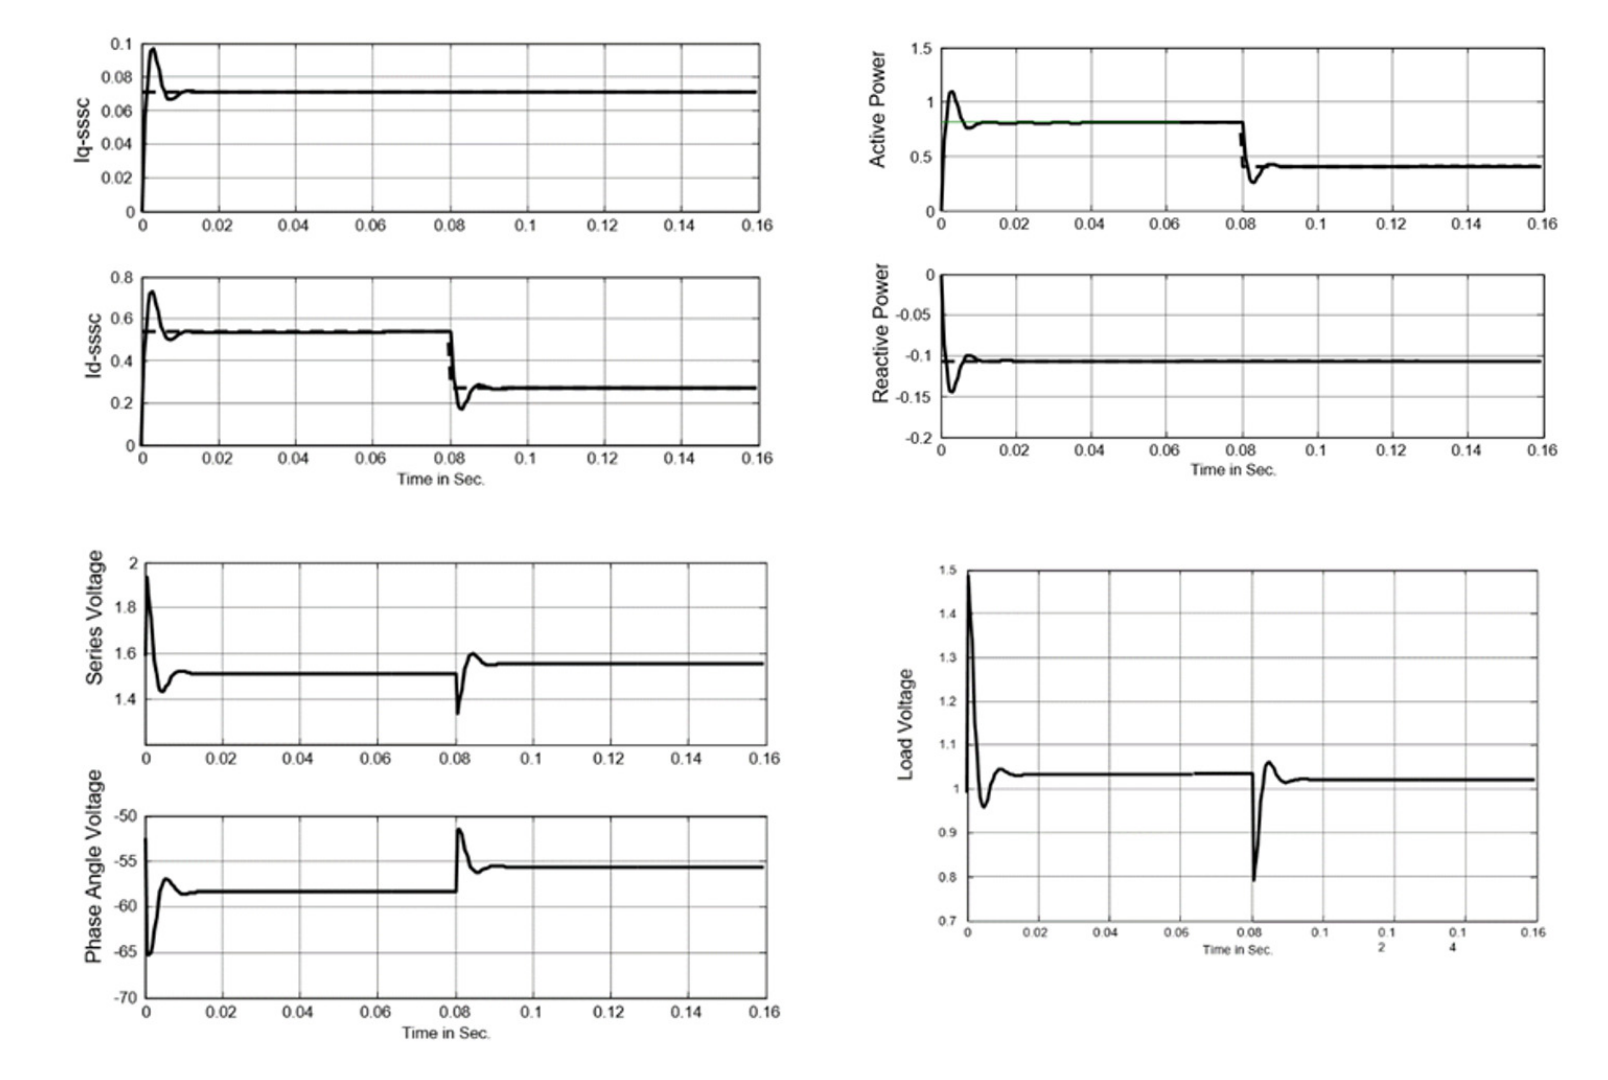
Figure 11. The transient performance of the SSSC in case of active power variation with